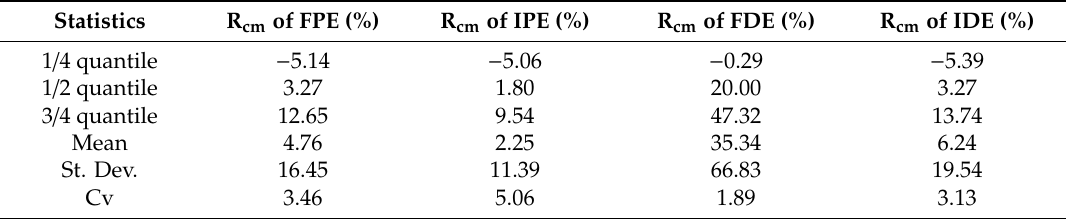
Table 2. Statistics of precipitation and drought extreme relative change rates in all of China.